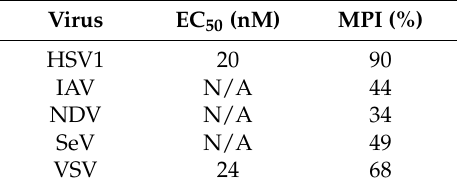
Table 2. EC 50 and MPI values for podofilox’s inhibition of infection by various viruses.